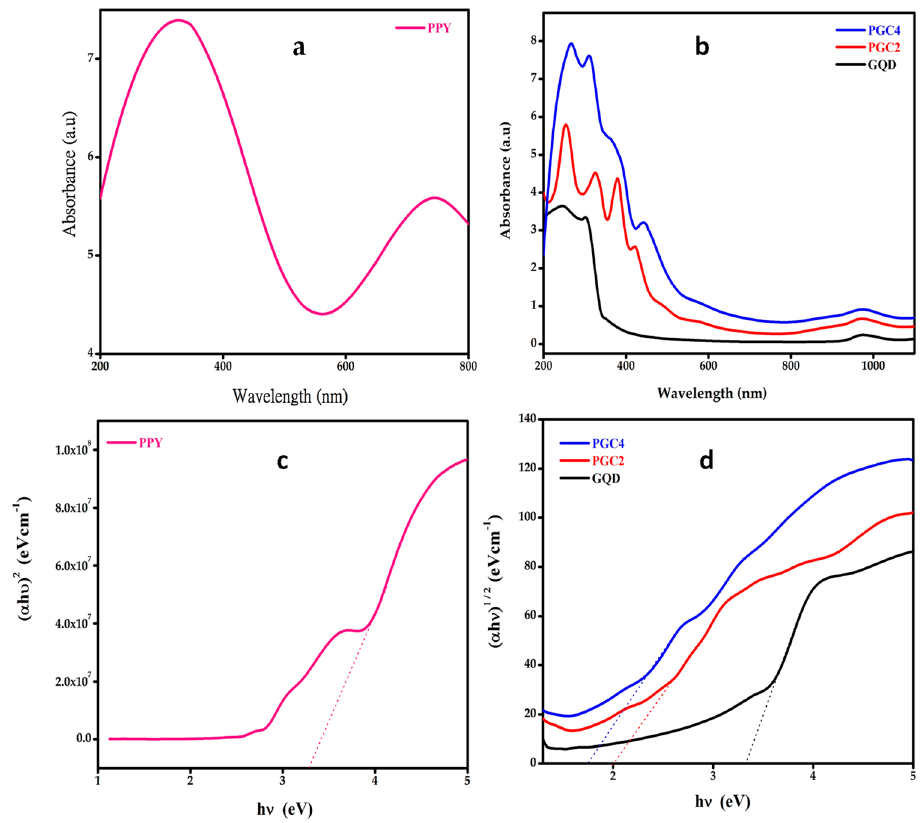
Figure 3. UV ‐ Visible spectra of ( a ) PPy. ( b ) GQDs, PGC2, and PGC4 composites and ( c ) Tauc Plots of ( α h ν ) 2 versus h ν for the determination of direct bandgap (E gd ) of PPy. ( d ) Tauc Plots of ( α h ν ) 2 versus h ν for the determination of direct bandgap (E gd ) of GQDs, PGC2, and PGC4. Thus, the electrical conductivity of polypyrrole increases in the presence of GQDs, due